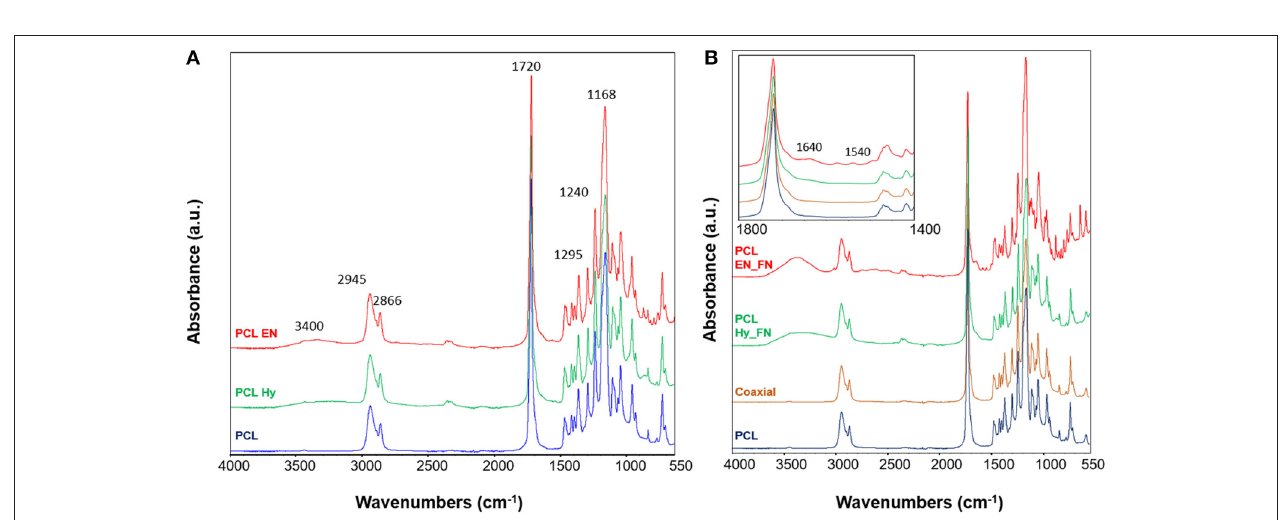
FIGURE 5 | ATR-FTIR spectra of the scaffolds after hydrolysis and EDC_NHS treatment (A) ; spectra of samples after the functionalization with fibronectin with three methods (B) with inset with a focus in the wavenumber range 1,800–1,400 cm − 1 . ATR-FTIR spectrum of neat PCL was used as control for all samples. Main bands discussed in the text are reported on the